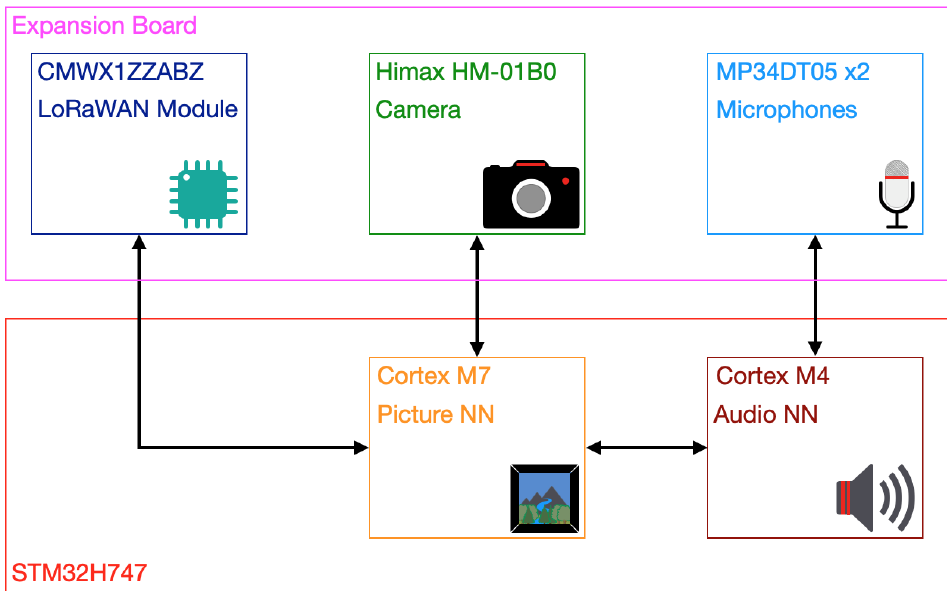
Figure 2. VSU prototype block